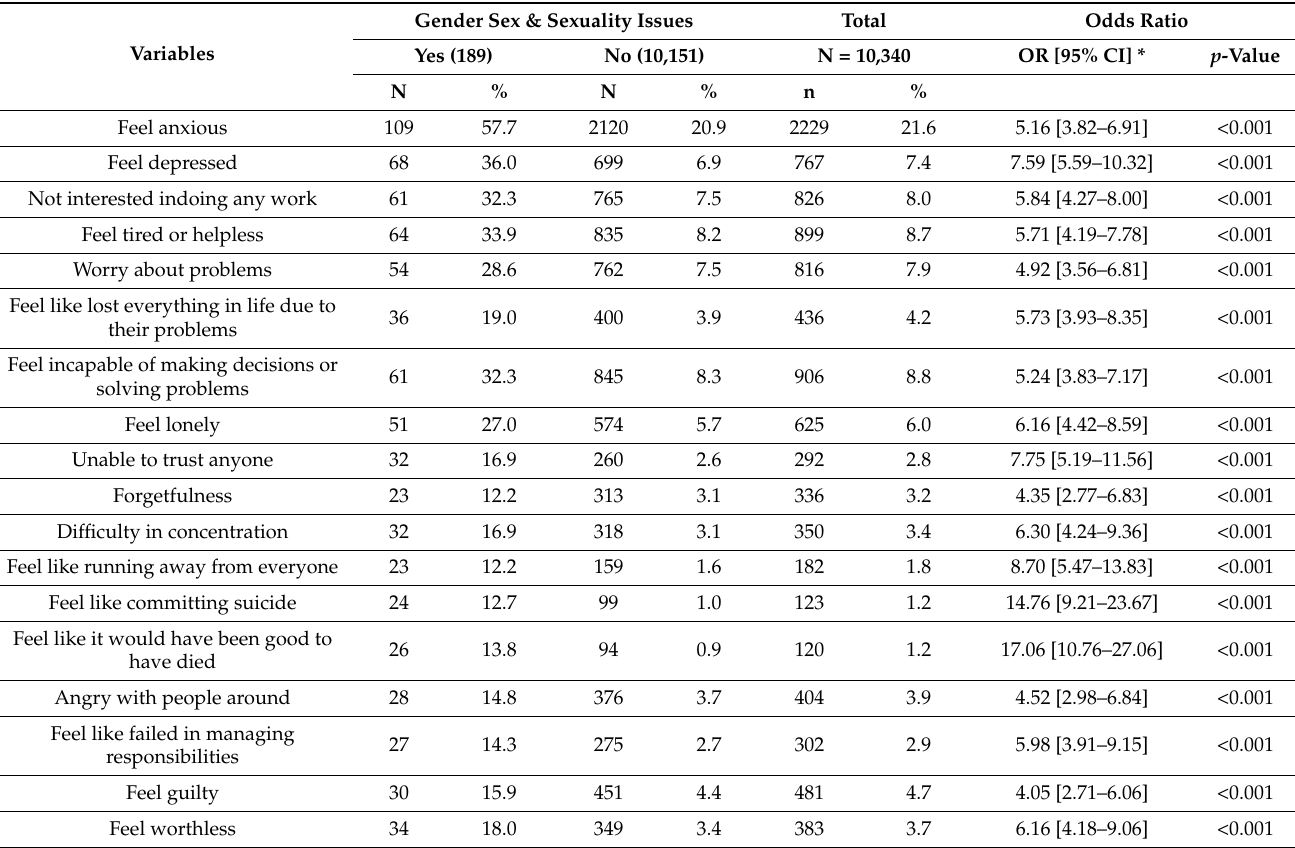
Table 3. Distribution of emotions experienced and gender, sex and sexuality issues among beneficiaries attending youth mental health promotion clinics during 2017–2020 in Karnataka. (N =